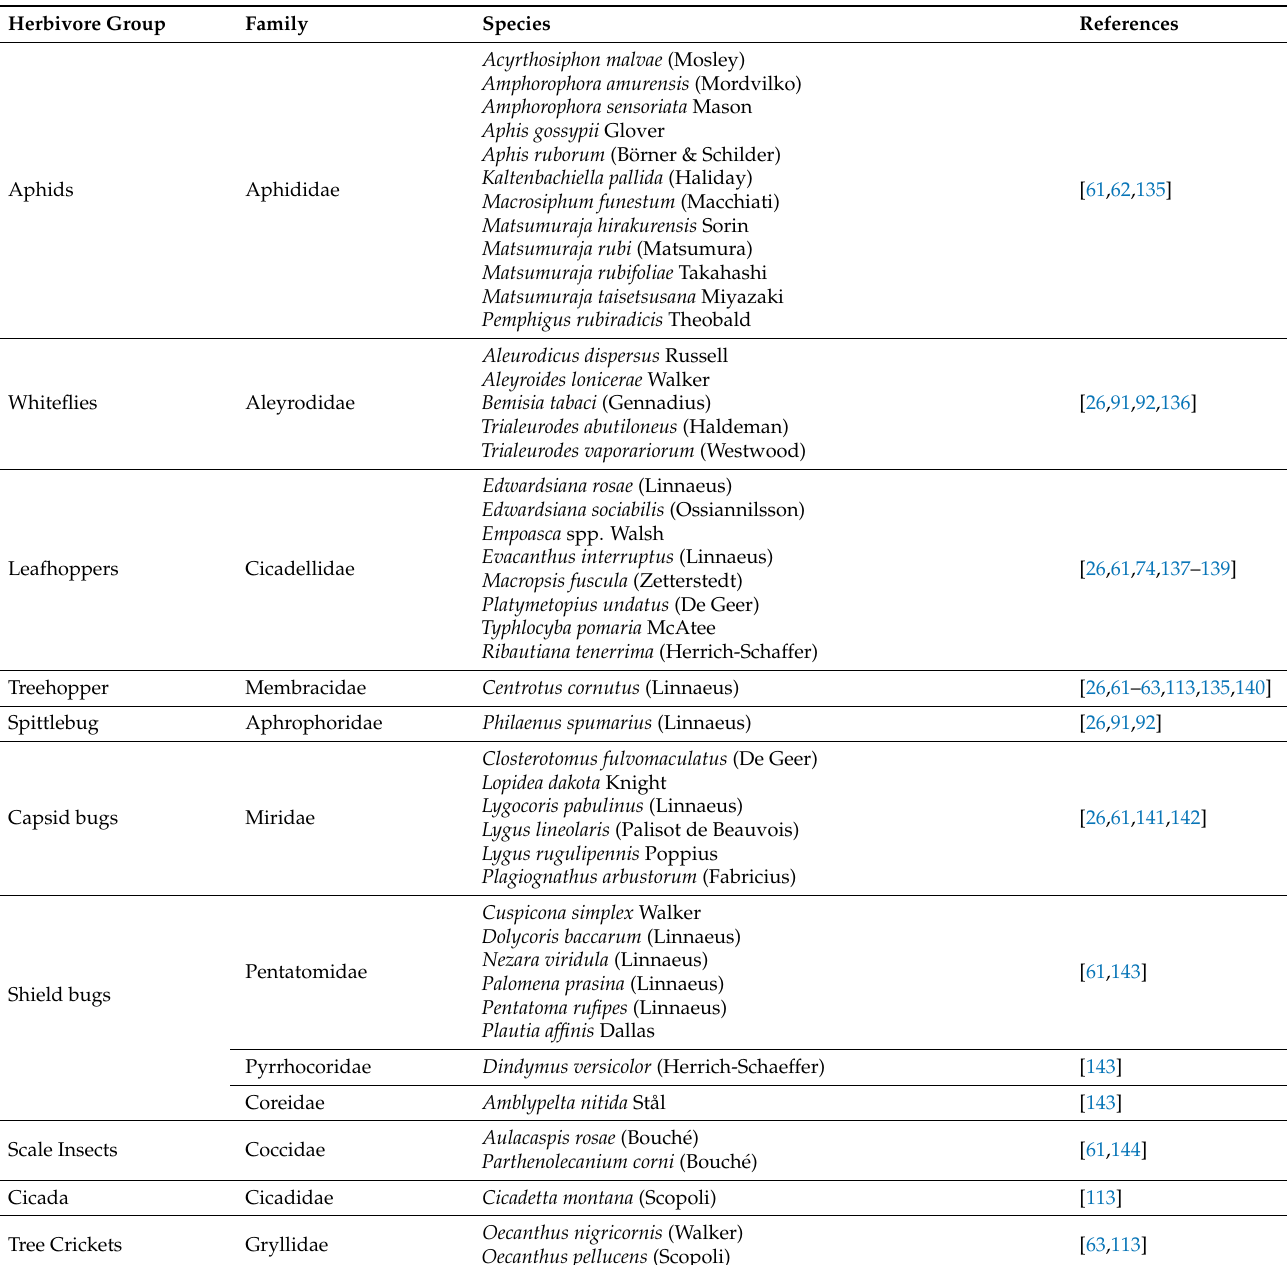
Table 3. Potential vector and non-vector invertebrate herbivores feeding on raspberry plants ( Rubus idaeus